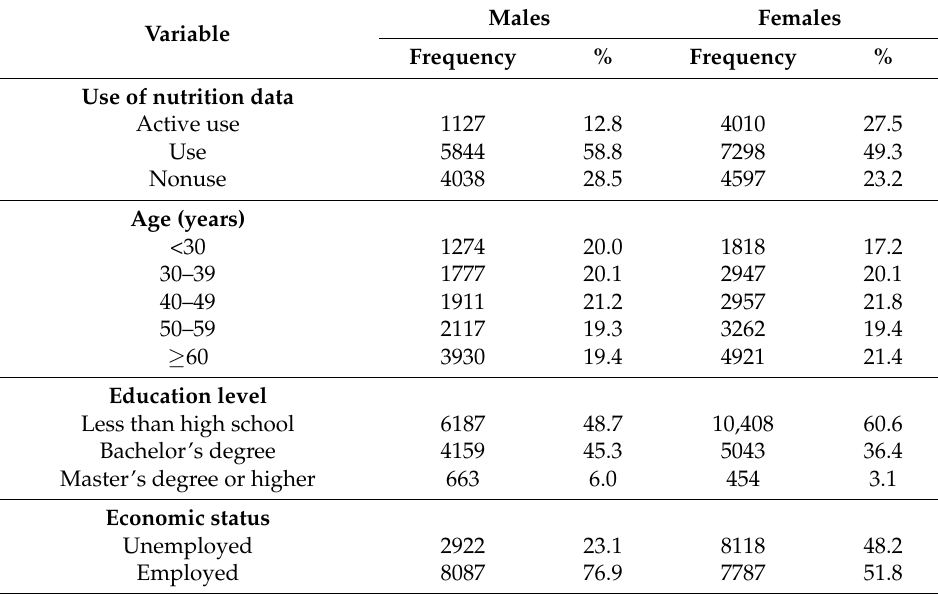
Table 1. General characteristics of the study population by